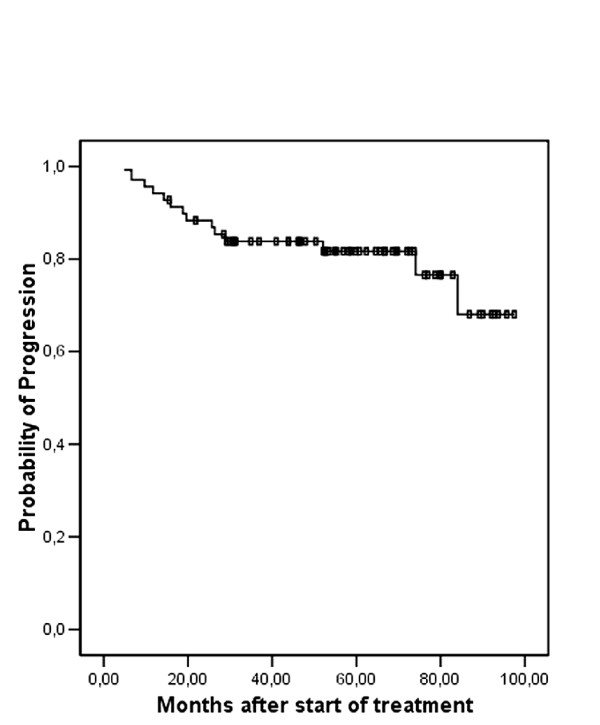
Relapse-free survival of 69 patients treated with paclitaxel/carboplatin for  early-stage (FIGO stages I-IIb) ovarian carcinoma.